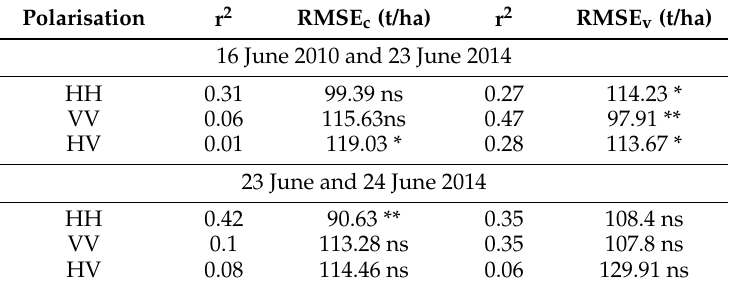
Table 9. Results of biomass regression models using S-band backscattering ( σ °) in Savernake and Wytham at 0.25 ha resolution. r 2 is the coefficient of correlation and RMSE c is the root mean square error calculated using cross-validation of the training plots (25 stands) for 2010 and 2014 in Savernake Forest and Wytham Woods. RMSE v is the error when applying the regression model to the validation plots (16 stands in Savernake Forest).